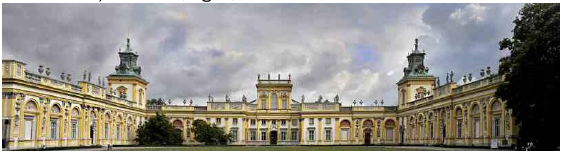
Figure. 1 Wilanów Palace, Warsaw, Poland